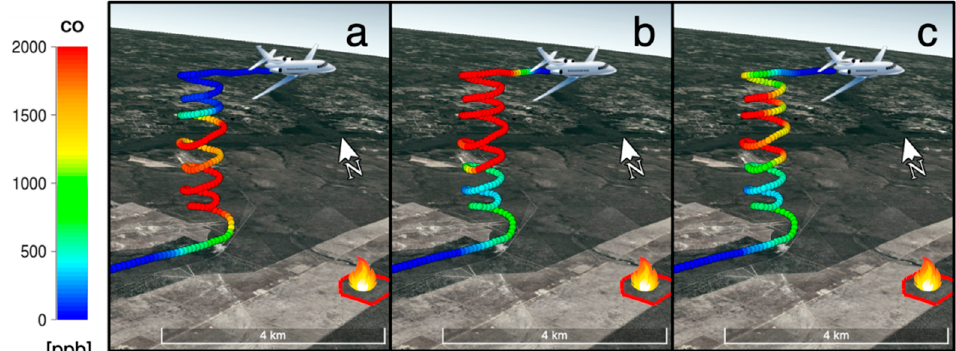
Figure 7. CO enhancements during the corkscrew transect (18:23–18:35 UTC) during the L2F prescribed burn. ( a ) Measured enhancements, and modeled enhancements from the ( b ) default and ( c ) ICM model simulations. The red polygon in the lower right represents the L2F burn plot.